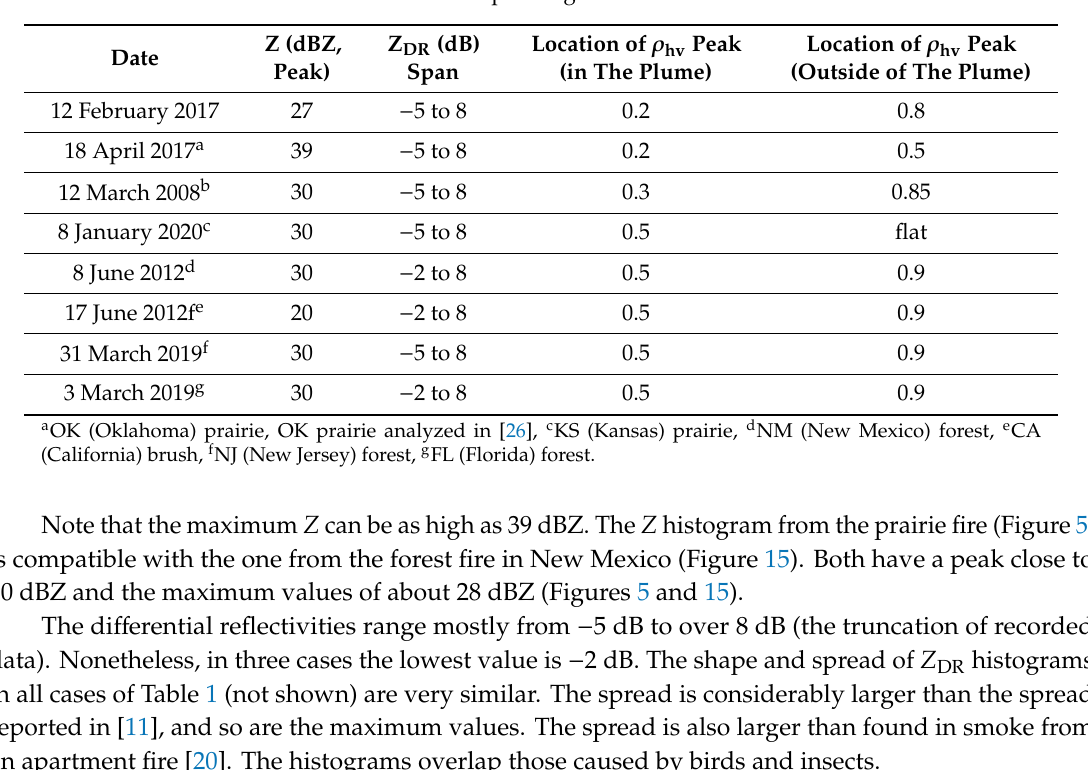
Table 1. Fires with the corresponding radar variables and